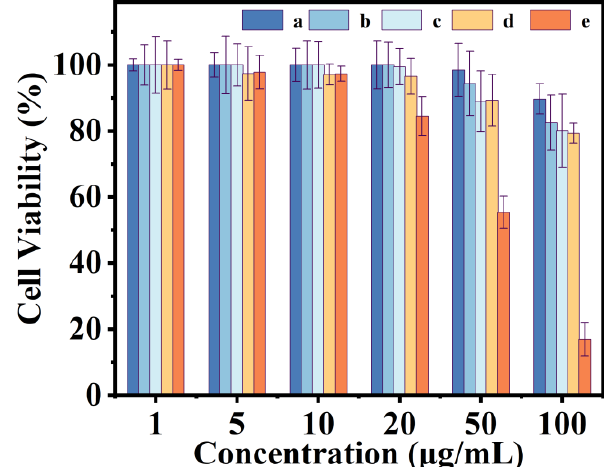
Figure 10. Cytotoxicity of synthetic materials against Hela cells after 48 h treatment. (a) PAA, (b) P(NA- AA)−0−0.1 , (c) P(NA- AA)−0−1 , (d) P(NA- AA)−0−1 0, and (e) NA. (b) P(NA-AA) − 0 − 0.1, (c) P(NA-AA) − 0 − 1, (d) P(NA-AA) − 0 − 10, and (e)